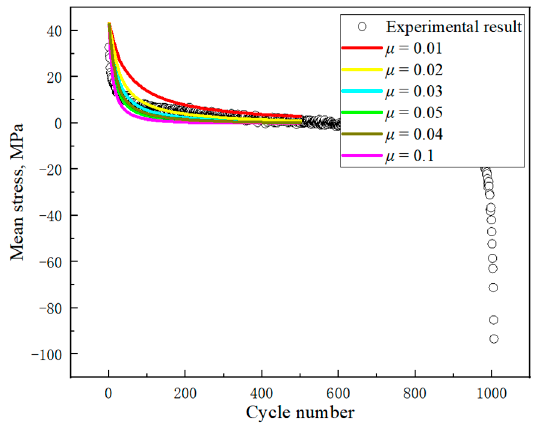
Figure 17. Results of sensitivity analysis for parameter μ .